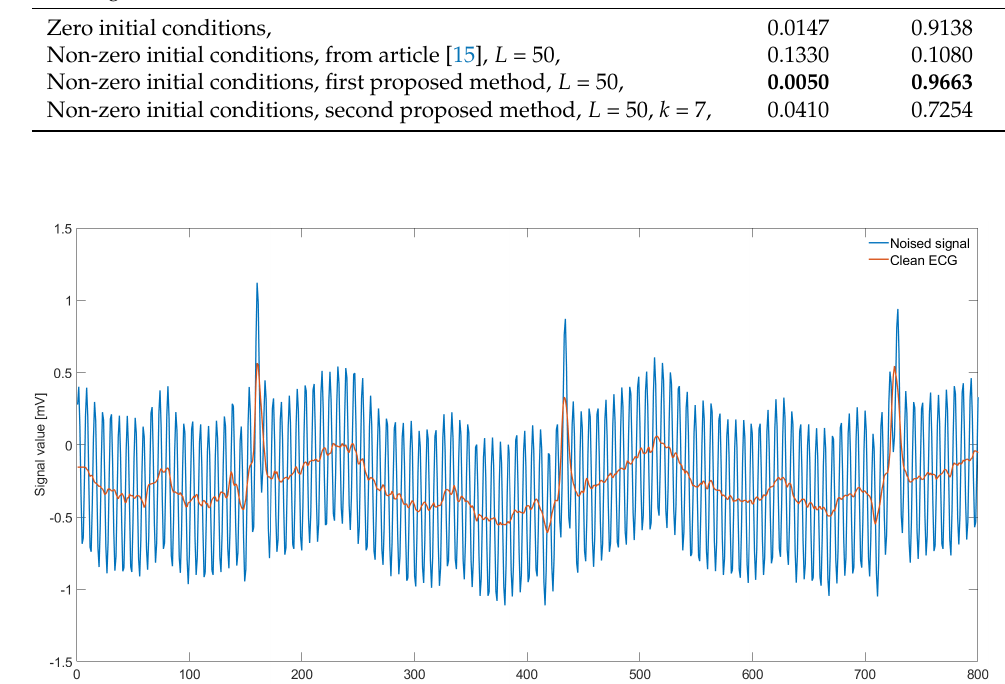
Figure 6. ECG 1 signal disturbed by the power line interference from the power line and the distortion- free signal.